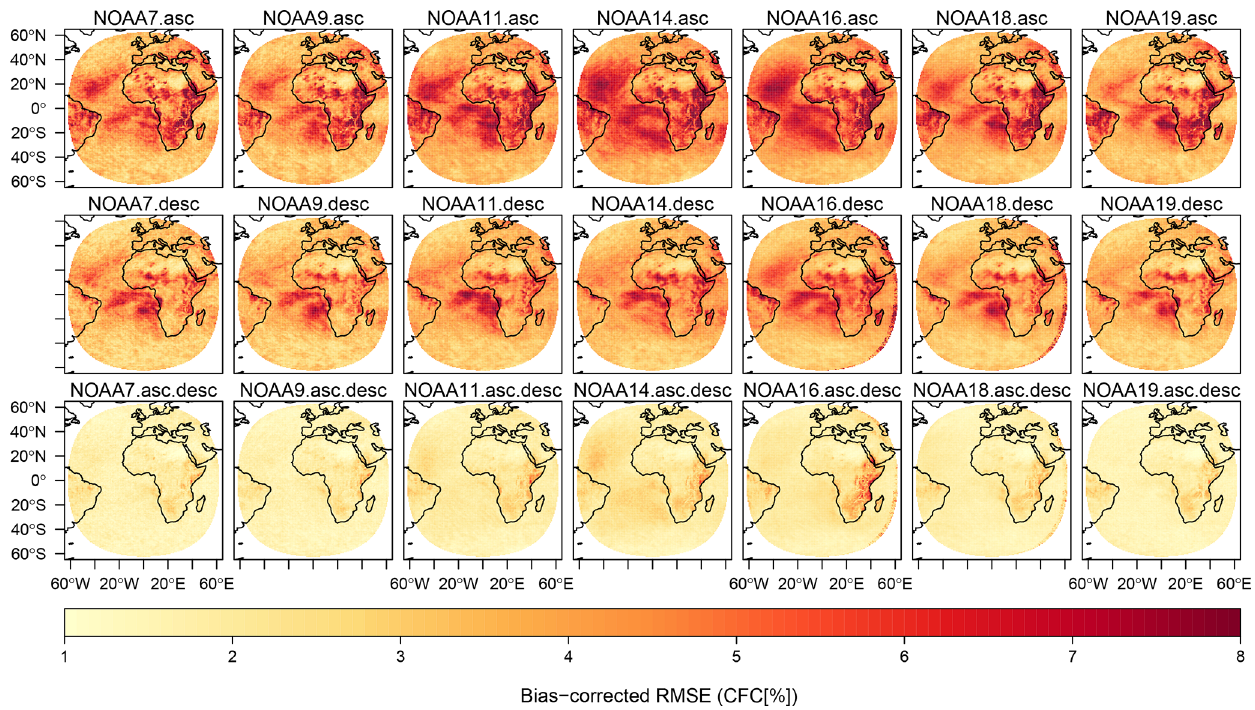
Figure 8. Bias-corrected root mean square error of CFC caused by the discrete sampling of the CFC diurnal cycle, presented for each afternoon (PM) NOAA satellite and each node (asc – ascending, desc – descending, and asc.desc – ascending and descending